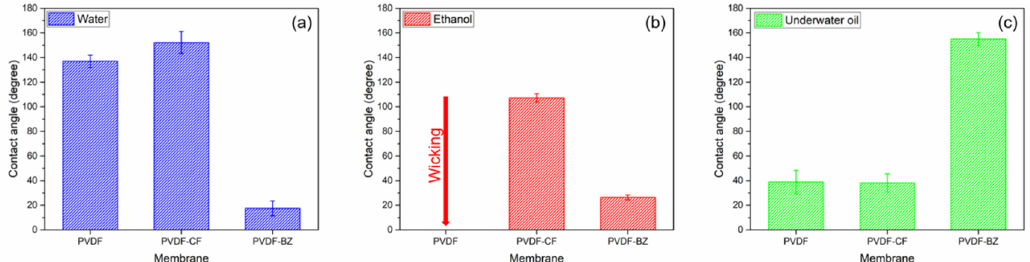
Figure 3. Water—( a ), ethanol—( b ), and oil–water ( c ) contact angles for PVDF, PVDF-CF and PVDF-BZ membranes. Droplet volume was 5 µL. The results represent the average of at least three measurements.